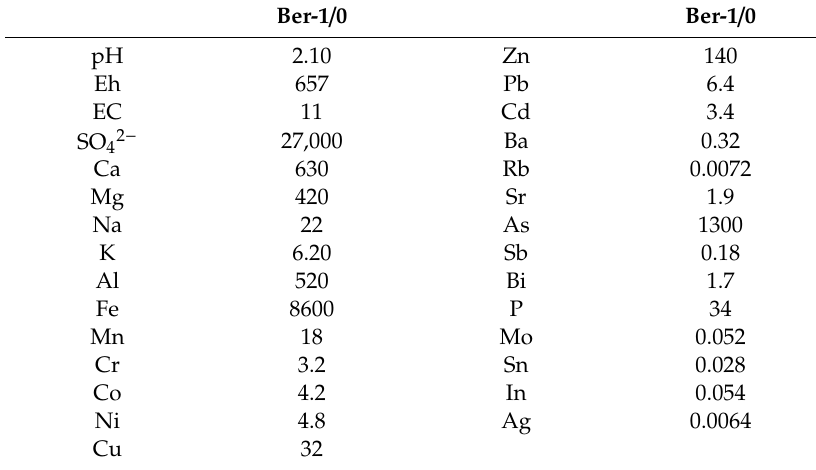
Table 1. Chemical composition of the Berikul pond water formed on the top of mine wastes, Eh in mV, electrical conductivity (EC) in mSm / cm, element concentration in mg / L.